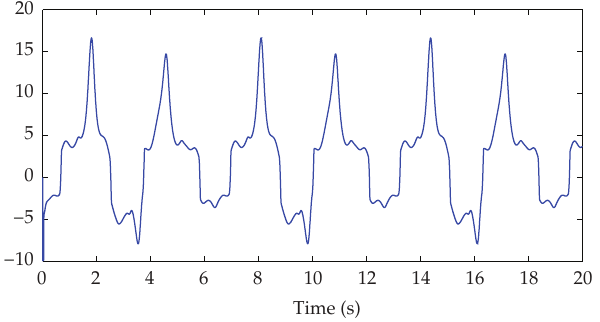
Figure 2: Control signal v (cid:5) t (cid:6)